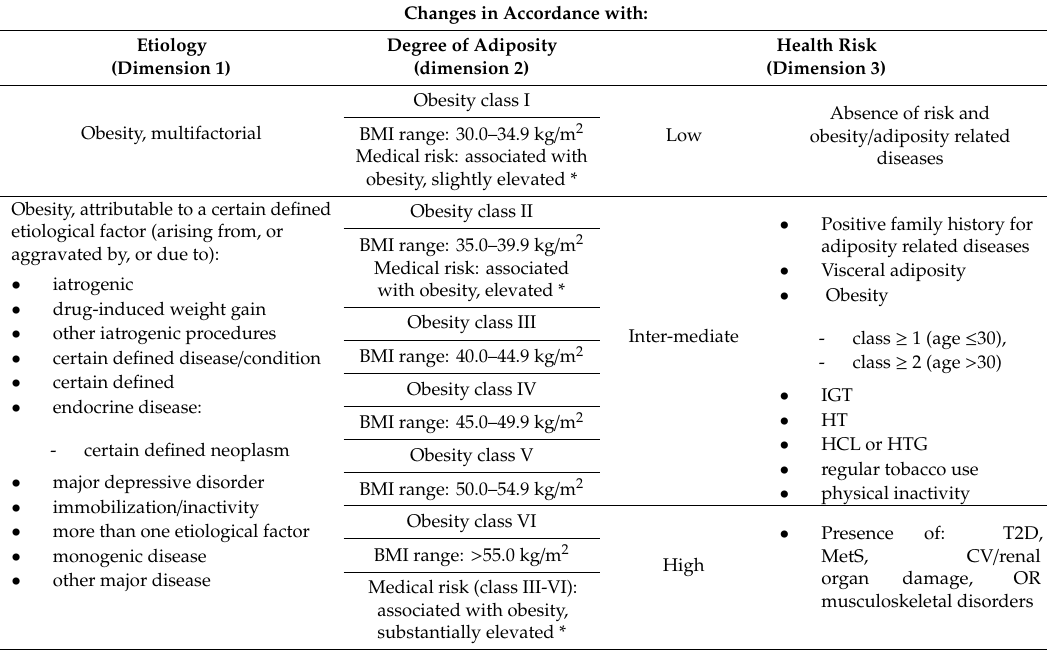
of the Study of Obesity (EASO), based on Heberand et. al,